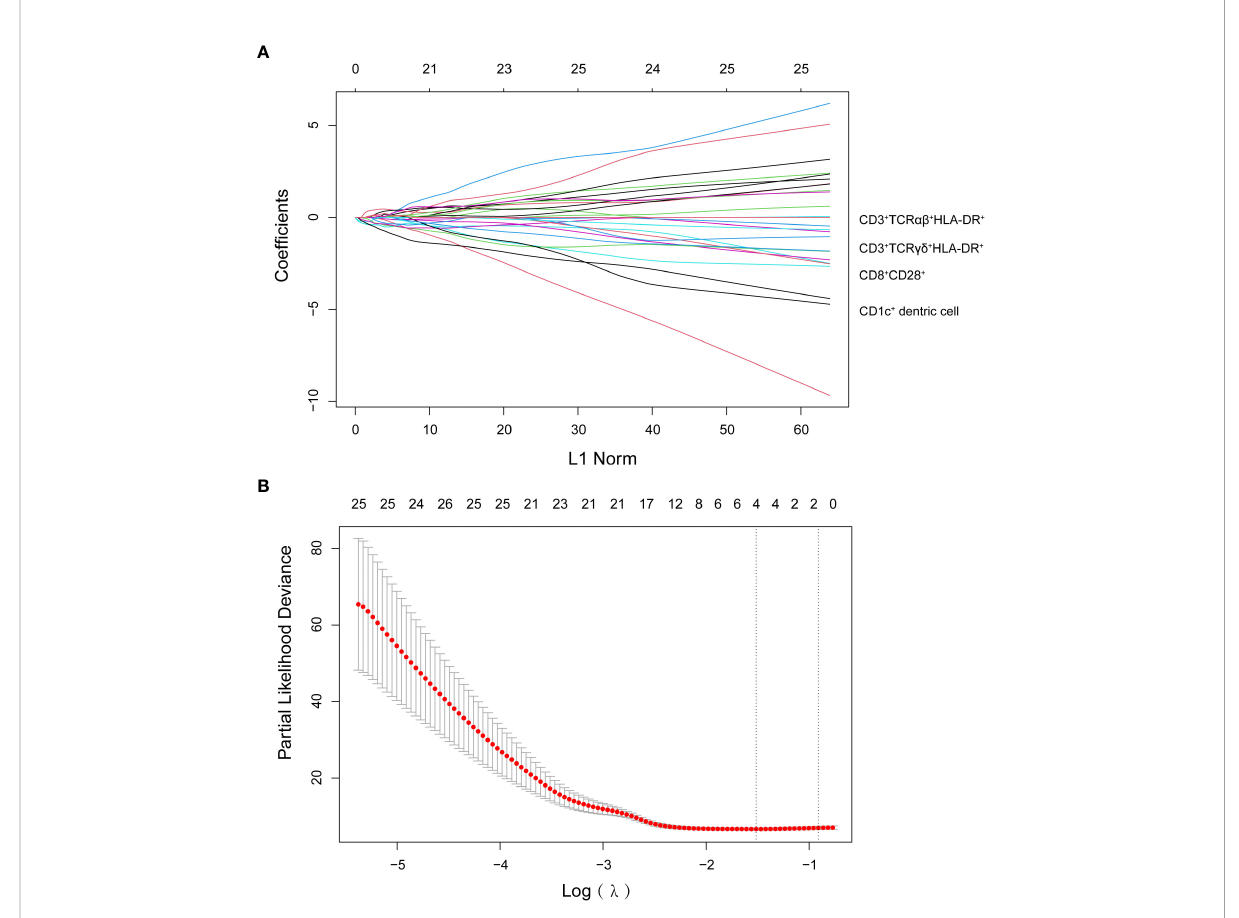
FIGURE 1 (A) LASSO coef fi cient pro fi les of the 66 lymphocyte subsets. (B) Ten-time cross-validation for tuning parameter selection in the LASSO